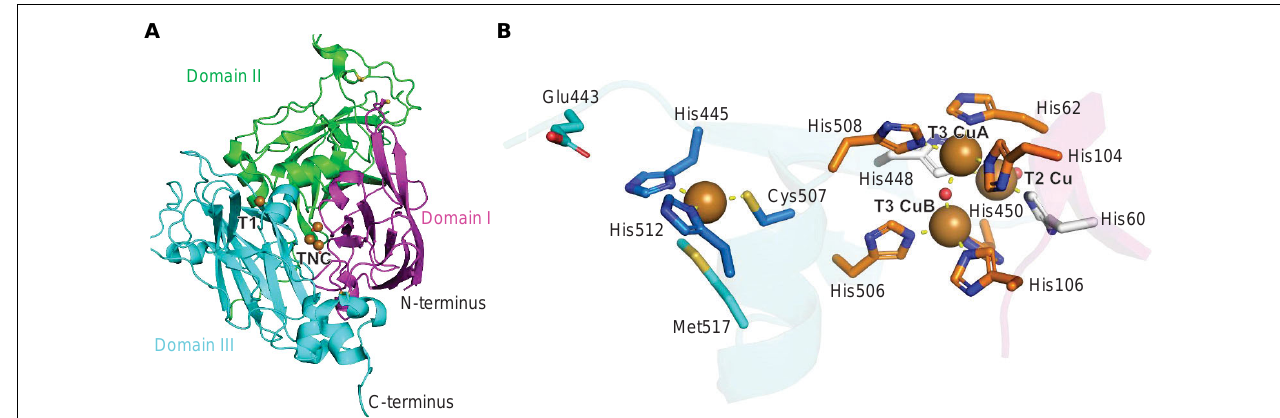
FIGURE 3 | Structure of a plant ascorbate oxidase. (A) Protein structure model of zucchini ascorbate oxidase (PDB ID: 1AOZ) (Messerschmidt et al., 1992). The three domains are highlighted in magenta, green and blue, the copper atoms are shown as brown spheres. (B) Copper center of zucchini ascorbate oxidase with T1 and TNC copper atoms and corresponding copper-binding residues. A water or hydroxide molecule is shown as a red sphere. Copper coordination is highlighted by yellow dashed